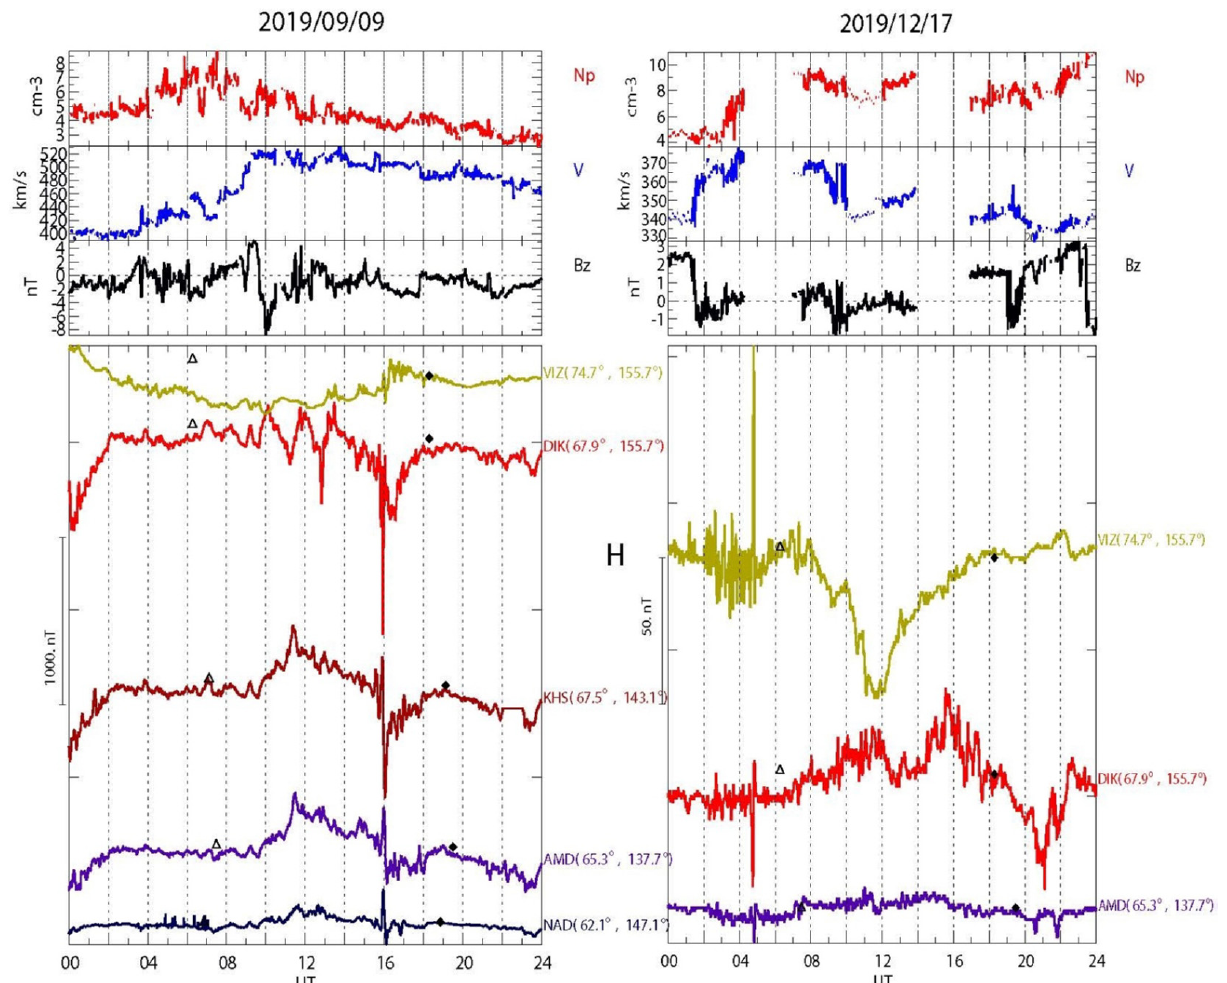
Figure 3. An example of localized magnetic disturbances (MPE) recorded on 9 September 2019 ( left-hand ) and 17 December 2019 ( right-hand ). The format of the figure is the same as in Figure 2.